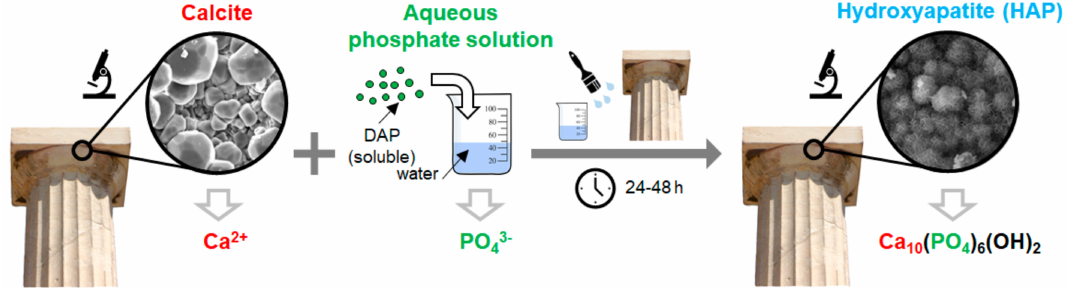
Figure 1. Scheme illustrating in situ formation of hydroxyapatite (HAP), as the reaction product between the substrate and an aqueous solution of a phosphate salt (typically DAP).